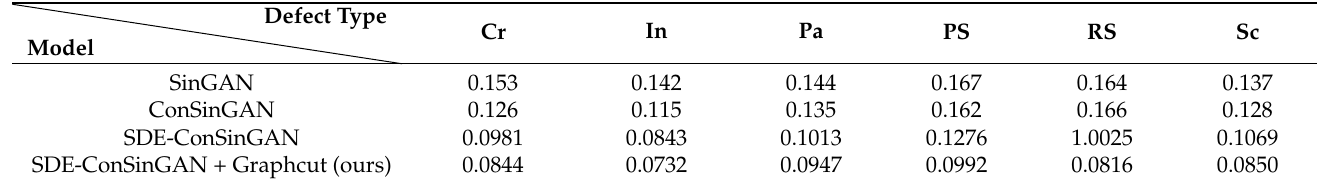
Table 3. SIFID scores of images generated via various image-generation